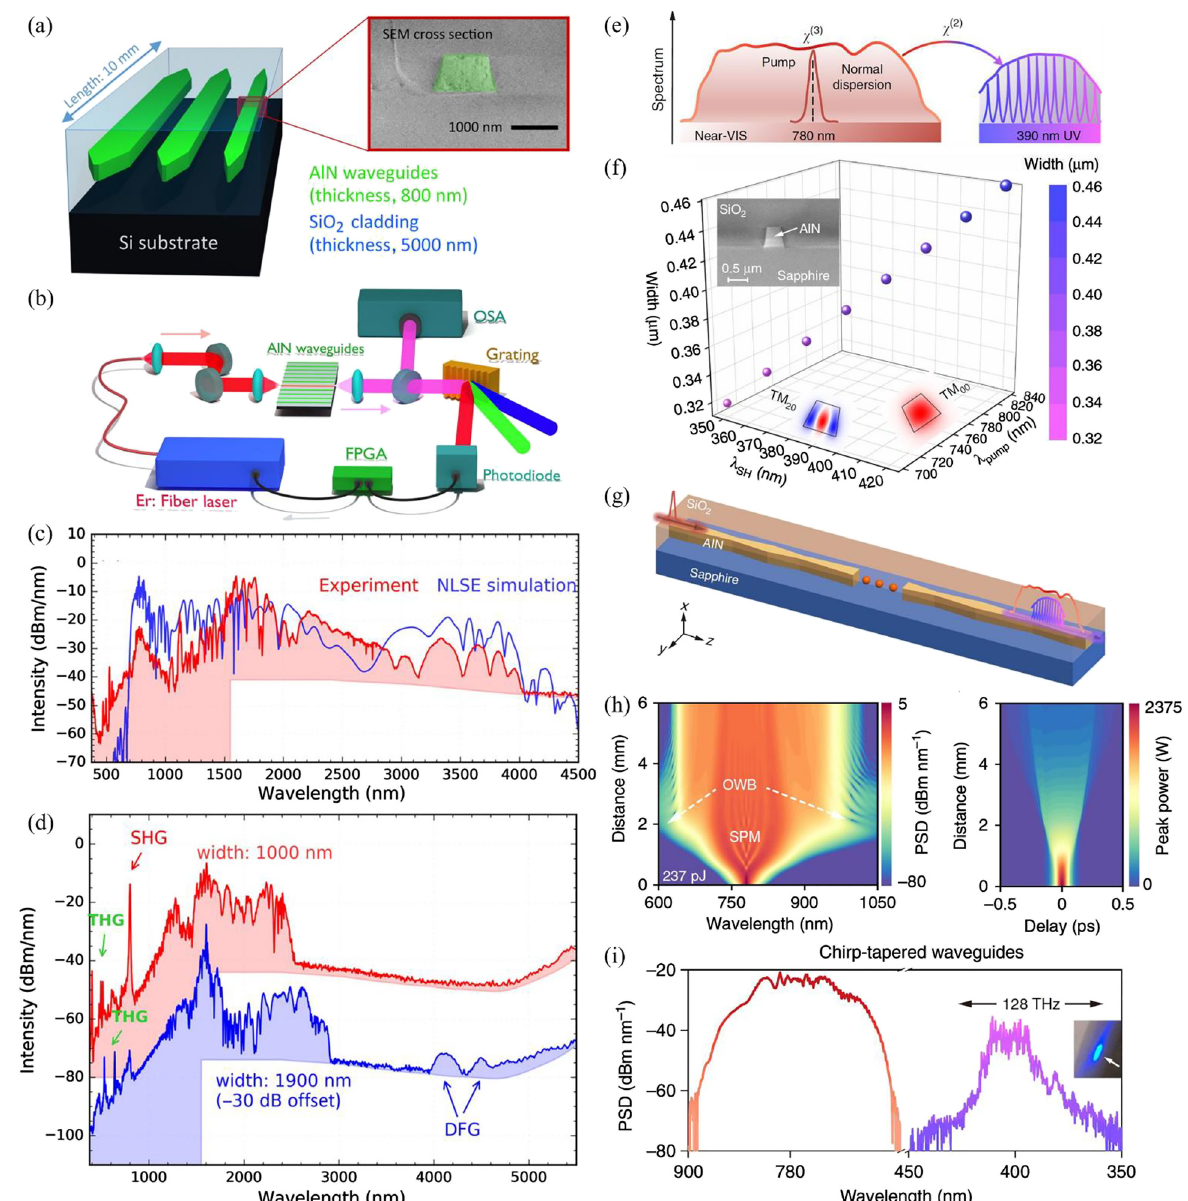
Figure 15: AlN-based integrated devices for supercontinuum generation (SCG). (a) Schematic of AlN waveguide embedded in SiO 2 on Si substrate for SCG. Inset shows the false-colored cross sectional SEM image of the fabricatedwaveguide.(b)ExperimentalsetupforSCG.Erbium- fi berfrequencycombat1560nmisusedaspump.TwoOSAsareusedtocapture the spectrum at the output, one grating-based OSA covers from visible to NIR wavelength range, and the other Fourier-Transform based OSA covers up into MIR wavelength range. Photodiode is used to detect f CEO , which is digitized by fi eld-programmable gate array (FPGA), and feedback to the fi ber laser pump source. (c) Experimental captured SCG spectrum from 3200 nm wide waveguide under pumping with TE 00 mode, and the simulated SCG spectrum by solving the NLSE. (d) Experimental captured SCG spectrum under pumping with TM 00 mode for waveguides with widthsof 1000 and1900nm.SHG, DFGandTHGcan alsobe observed.(a) – (d)Adaptedwith permissionfrom [133],copyright (2017) by the American Physical Society. (e) Schematic of SCG in near-visible wavelength (red curve) through χ (3) nonlinear effect, and simultaneous conversion into the UV frequency comb (purple curve) through χ (2) nonlinear effect. (f) Phase matching condition between near- visible TM 00 mode and UV TM 20 mode from calculation. Insets: mode intensity pro fi les and the cross sectional SEM image of the fabricated waveguide. (g) Schematic of chirp-modulated taper waveguide, formed by cascading eight linear-tapered segments. (h) Simulated SCG in spectrum domain (left panel) and time domain (right panel). (i) Captured spectra generated by the chirped-tapered waveguide at near-visible andUVwavelengthrange.Inset: fl uorescenceonawhite paperinducedbyUV light.(e) – (i)Adaptedwith permissionfrom